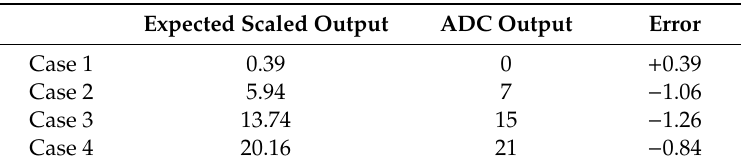
Table 1. Output error for di ff erent input